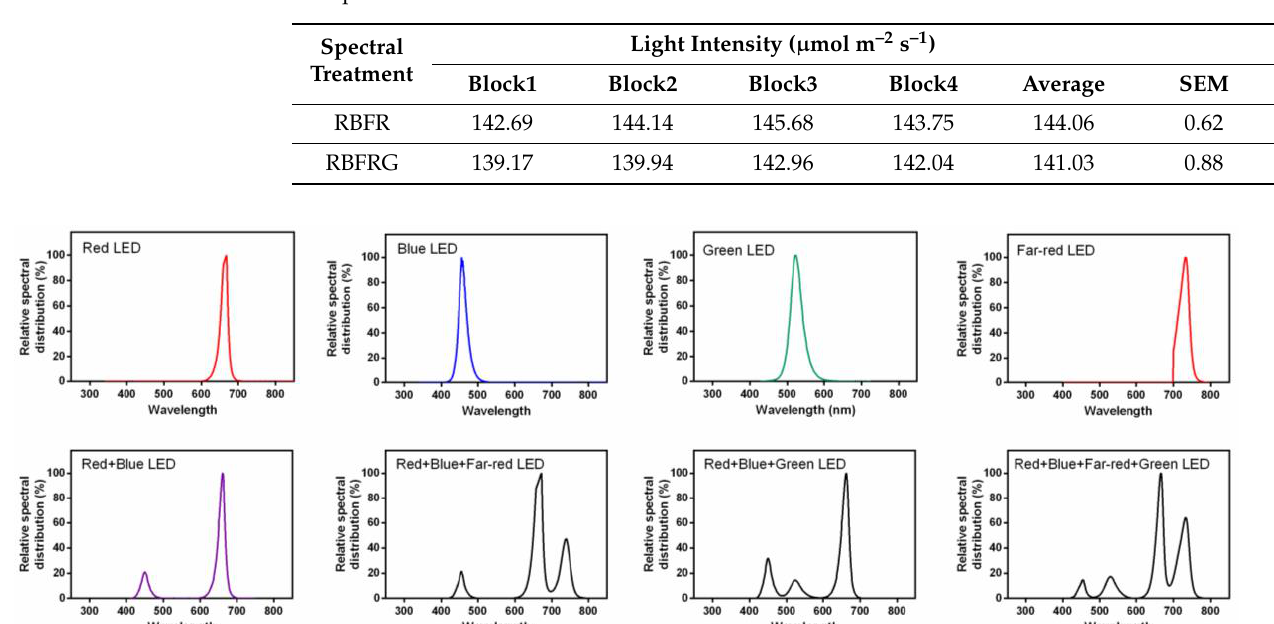
Biology 2022 , 10 , x Figure A1. The relative spectral distributions of narrow-band LEDs and the combined LEDs.